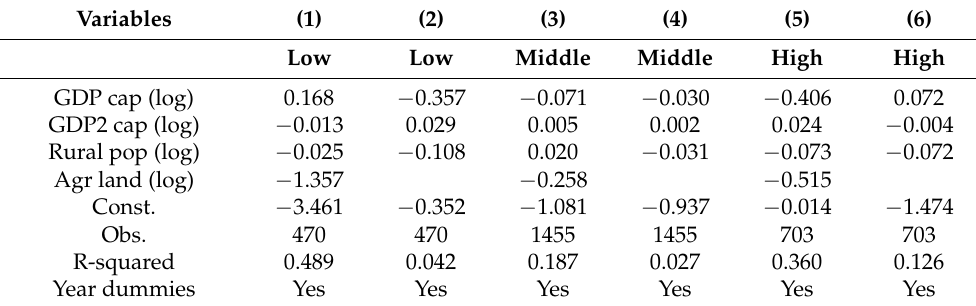
Table 4. Long-run equations, income